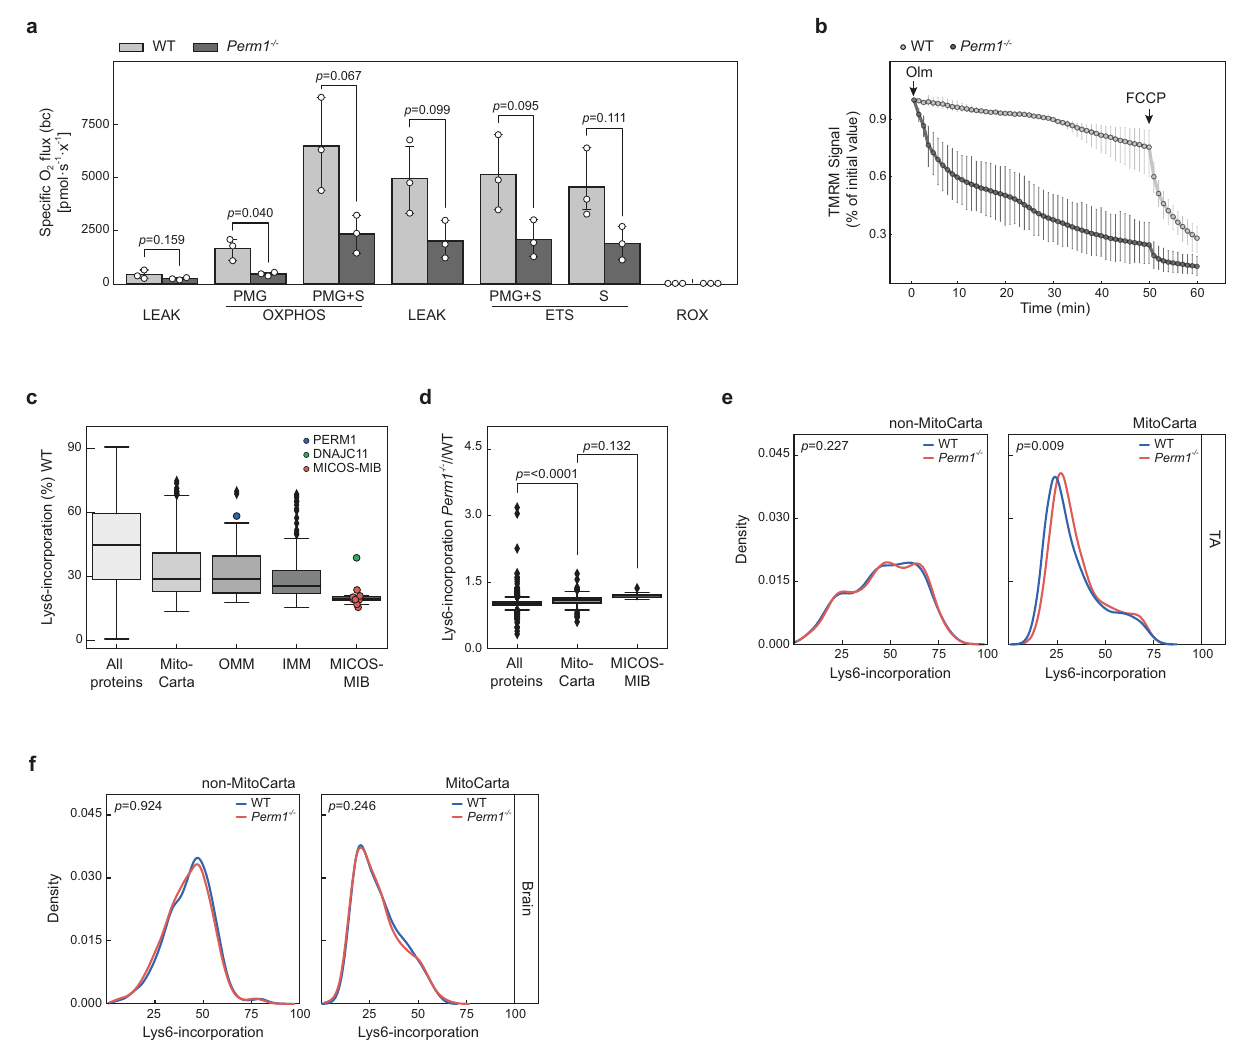
Fig. 4 Perm1 -de fi cient muscles show reduced oxygen fl ux and faster turnover of mitochondrial proteins. a High-resolution respirometry of isolated muscle mitochondria showing decreased speci fi c oxygen fl ux in isolated Perm1 − / − mitochondria compared to wild-type controls ( n = 3 mice per group). b FDB muscle fi bers were loaded with 2.5 nM TMRM. Arrows indicate the addition of 5 µ M oligomycin and 4 µ M FCCP ( n = 10 fi bers in wild-type, n = 20 fi bers in Perm1 − / − ). c Comparison of the Lys6-incorporation rates of all proteins, mitochondrial proteins, OMM proteins, IMM proteins, and proteins of the MICOS – MIB complex in wild-type mice fed a SILAC diet for 14 days ( n = 3 mice per group). DNAJC11 and PERM1 had higher incorporation rates than other MICOS – MIB proteins. d Ratios of Perm1 − / − to wild-type control Lys6-incorporation rates for MitoCarta 2.0 proteins and MICOS – MIB proteins in comparison to the complete TA muscle dataset after feeding with a SILAC diet for 14 days. Enhanced labeling of mitochondrial proteins and MICOS – MIB proteins was observed in Perm1 − / − mice ( n = 3 mice per group). e , f Density plots of the ratios of Perm1 − / − to wild-type control Lys6-incorporation for non-MitoCarta 2.0 and MitoCarta 2.0-annotated proteins, showing enhanced labeling of mitochondrial proteins in Perm1 − / − ( e ) TA but not in ( f ) Perm1 − / − brain. Data ( a ) are presented as mean values ± 0.95 CI. Box plots ( c , d ) represent the median, 25th, and 75th percentiles, maximum and minimum are connected through whiskers. Outliers are de fi ned as Q 1 – 1.8 IQR and Q 3 + 1.8 IQR. ( a ) paired two-sided Student ’ s t test, ( d , e , f ) unpaired two- sided Mann-Whitney U -test. Source data are provided as Source Data fi le and in Supplementary Data 3. PMG (pyruvate, malate, glutamate), S (succinate), ETS (electron transfer system), ROX (residual oxygen consumption), Olm